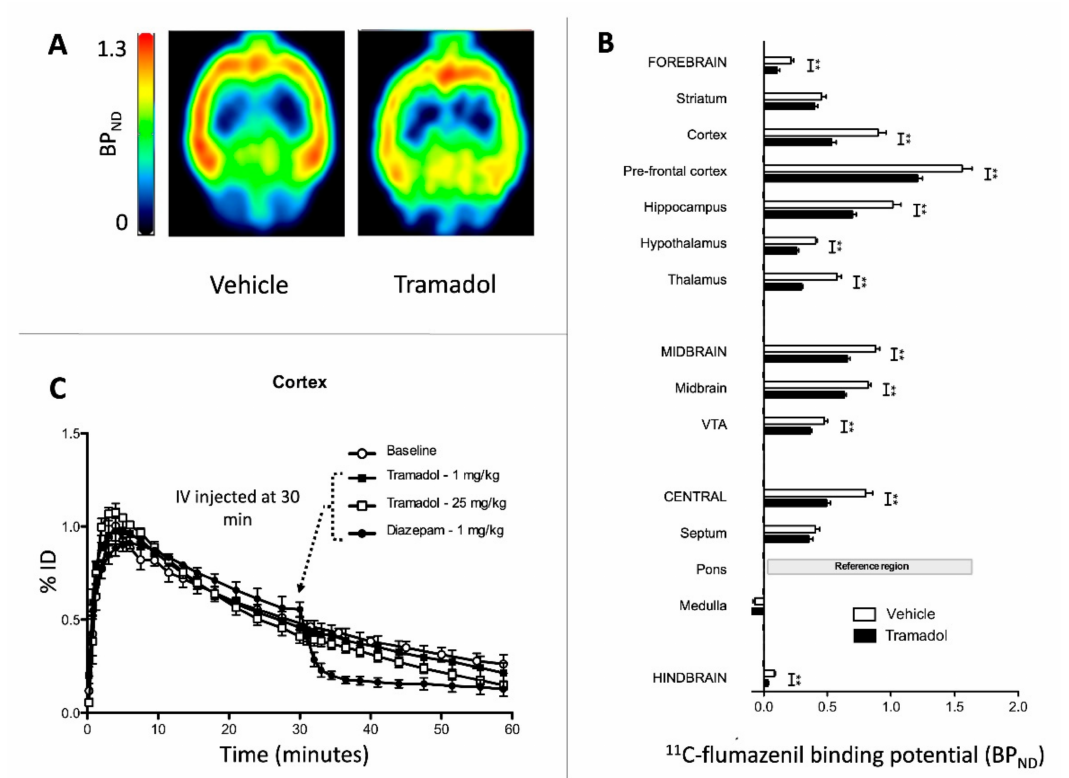
Figure 4. Effects of tramadol on 11 C-flumazenil binding to the brain. Parametric PET images displaying the regional binding of 11 C-flumazenil (BP ND ) without (Vehicle) or with (Tramadol) pre- treatment with intraperitoneal 75 mg/kg tramadol, 15 min before intravenous (i.v.) 11 C-flumazenil are shown in ( A ). The corresponding BP ND in selected brain regions in rats receiving either baseline 11 C-flumazenil (Vehicle group, white) or tramadol injection (Tramadol group, black) are shown in ( B ). Results are expressed as mean ± SEM. (N = 5/group). ** p < 0.01. Displacement experiments are reported in ( C ), displaying 11 C-flumazenil time activity curves in the cortex, i.v. injected alone (white circle), with 1 mg/kg tramadol i.v. (black square), 25 mg/kg tramadol i.v. (white square) or 1 mg/kg diazepam i.v. (black circle) injected 30 min after the beginning of the PET acquisition. Results are expressed as mean ± SEM (N =